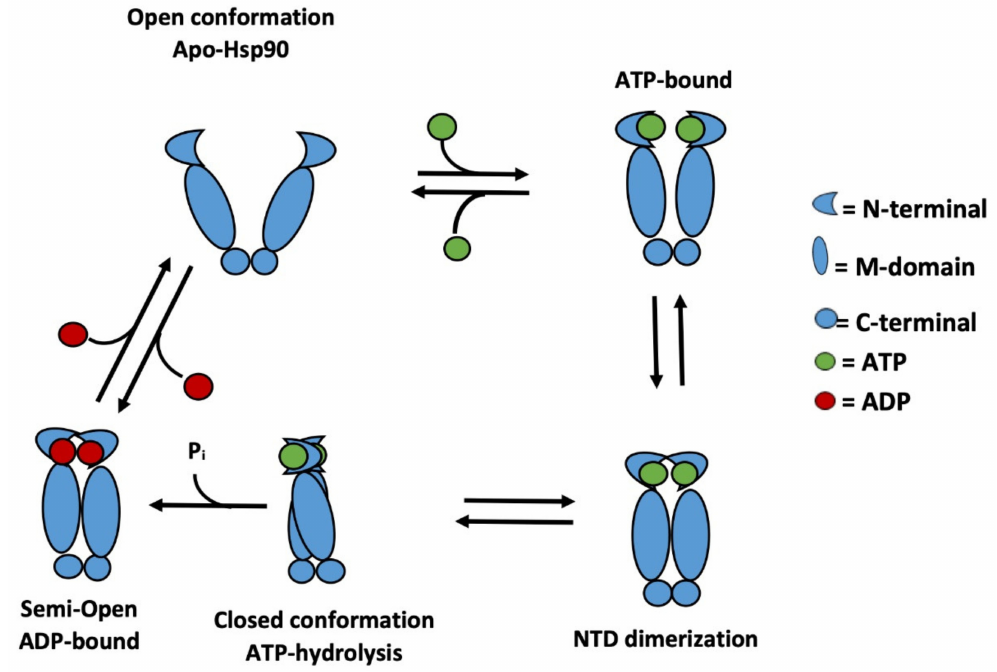
Figure 2. Schematic representation of the Hsp90 ATPase cycle [14].